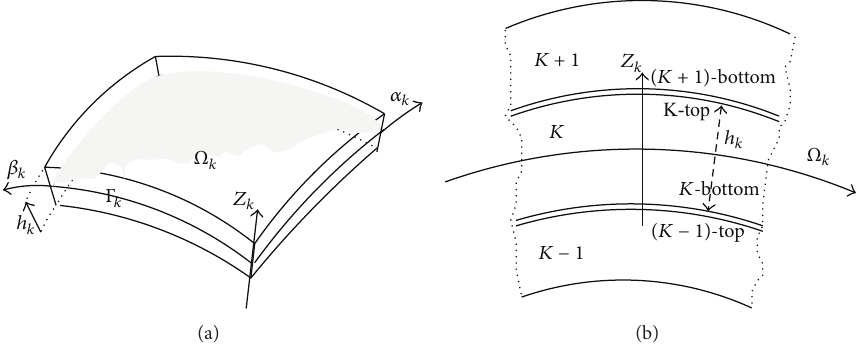
Figure 3: Geometry and notations for a multilayered shell (doubly